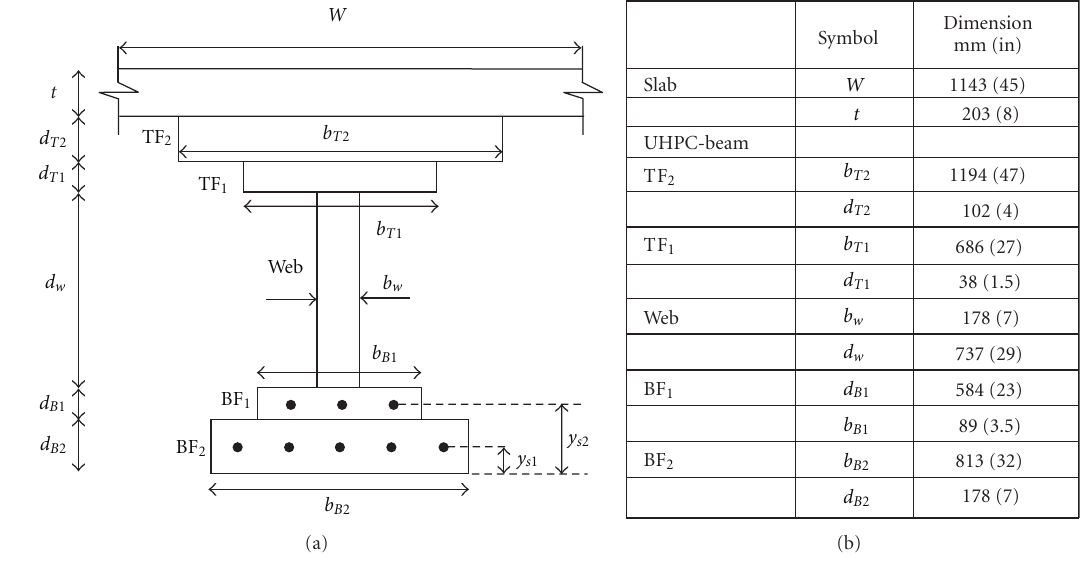
Figure 5: Idealization of the UHPC PCBT-45 VDOT section with